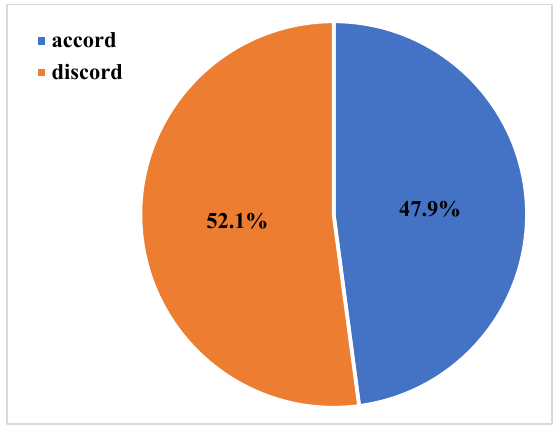
Figure 5. Slope type selection consistency .